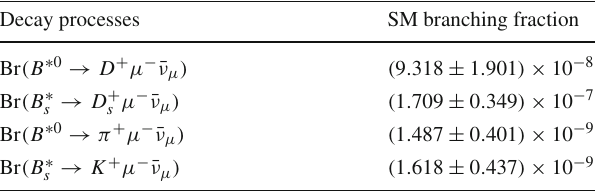
→ P μ ¯ ν μ processes in the Stan- d , s